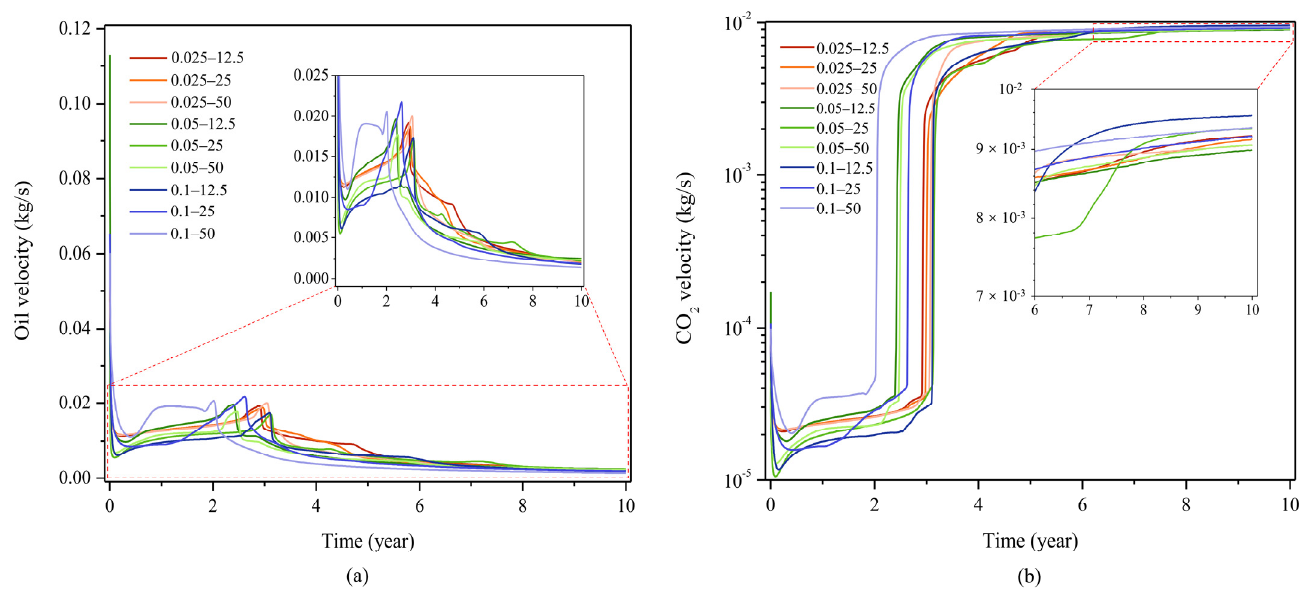
Figure 15. Velocity of fluid at production grid. (a) velocity of oil; (b) velocity of CO 2 .